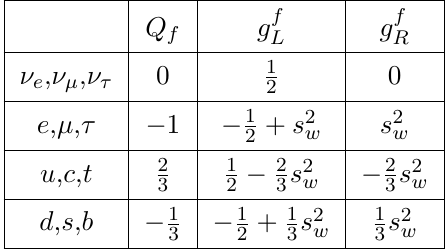
Table 2 . SU(2) L (cid:2) U(1) Y quantum numbers of the particles in the Standard Model.